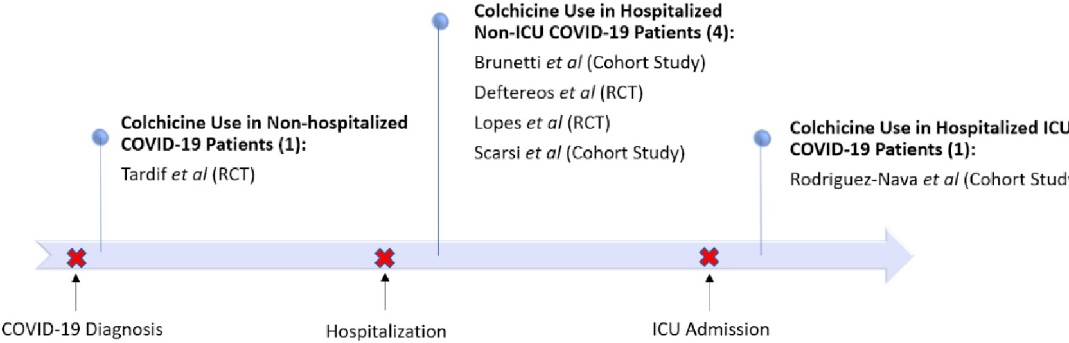
Fig 3. Studies examining colchicine at various care